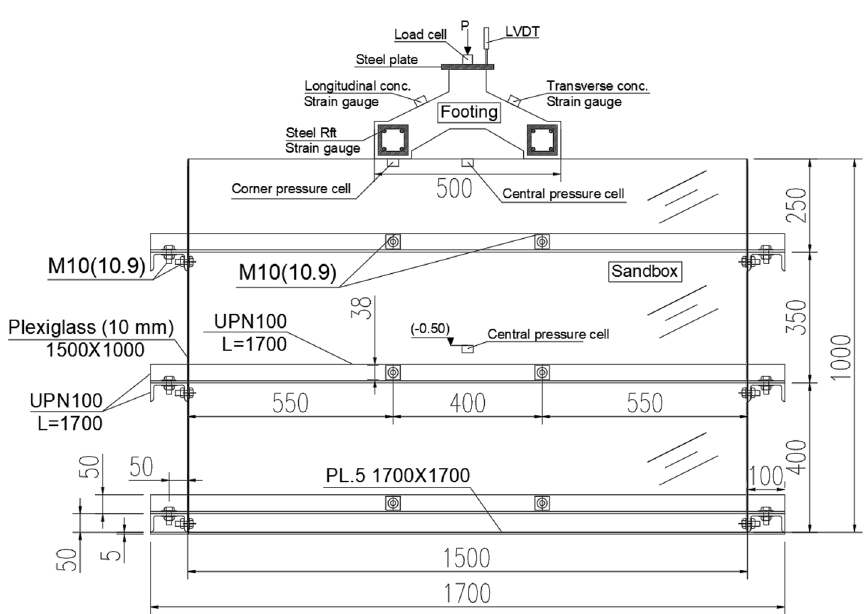
Fig. 7 Sandbox dimensions and instrumentation